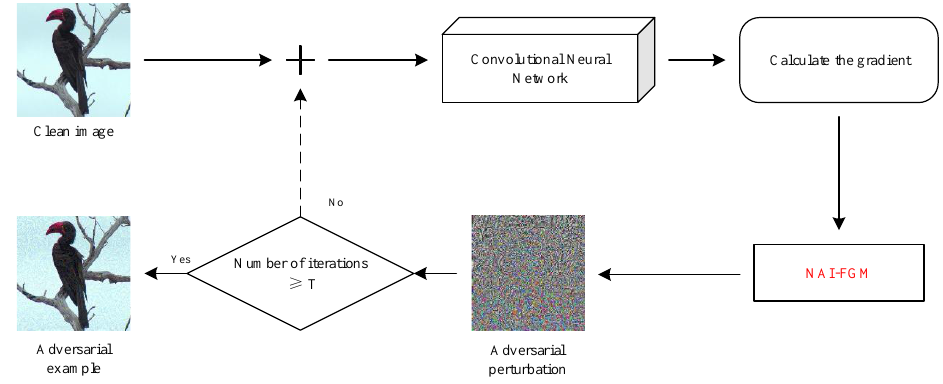
Figure 3. Principle of the attack based on the NAI-FGM